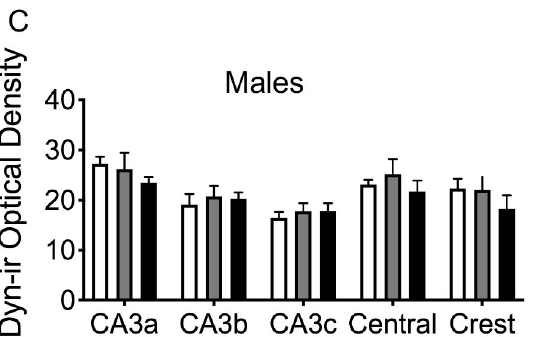
Figure 7. Light microscopic localization of Dyn labeling in the mossy fiber pathway from WT, MOER, and NOER mice. ( A ) Representative section of the dorsal hippocampus showing regions sampled (circles) for densitometry from the crest and central portion of the hilus of the DG and from the stratum lucidum (SLu) of CA3a, b, and c. ( B , C ) There were no significant differences between genotypes in the relative optical density of Dyn labeling in any region of the DG or CA3 from either female or male mice ( n = 4 WT, 6 MOER, and 6 NOER females; n = 4 each for WT, MOER, and NOER males); scale bar = 100 microns.